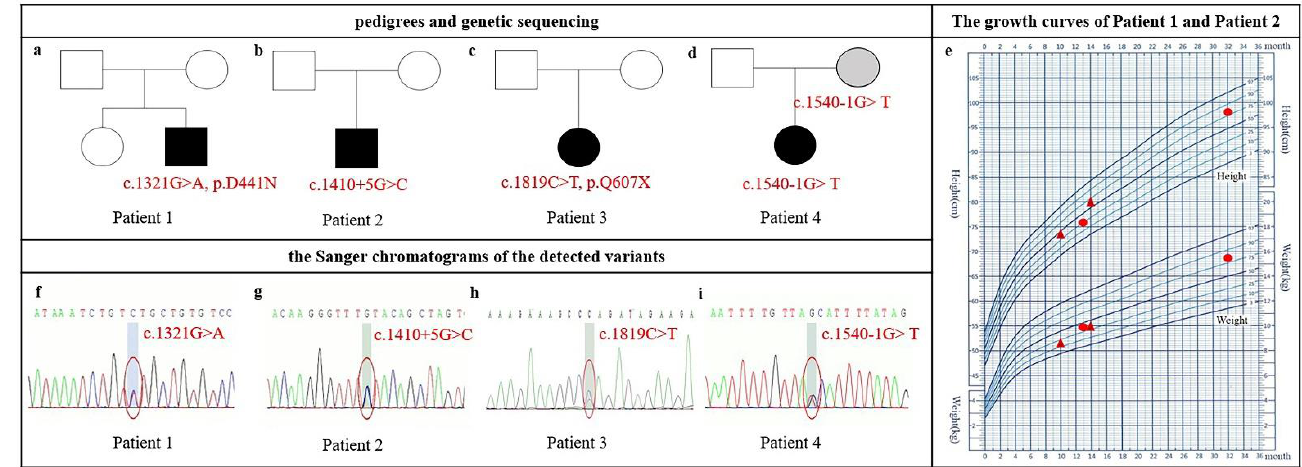
Figure 1. Pedigrees, physical growth curves, and Sanger chromatograms of Chinese patients with pathogenic NAA15 variants. ( a – d ) Pedigree. NDD-affected individuals are indicated by solid squares (male) or solid circles (female). Patient 4’s mother is labeled gray because her intelligence is not available. ( e ) Growth curves of patient 1 and patient 2; catch-up growth was noticed in patient 1 at 13 months and 32 months old (red circle) and in patient 2 at 10 and 14 months old (red triangle). ( f – i ) Sanger chromatograms of the detected variants in NAA15 .